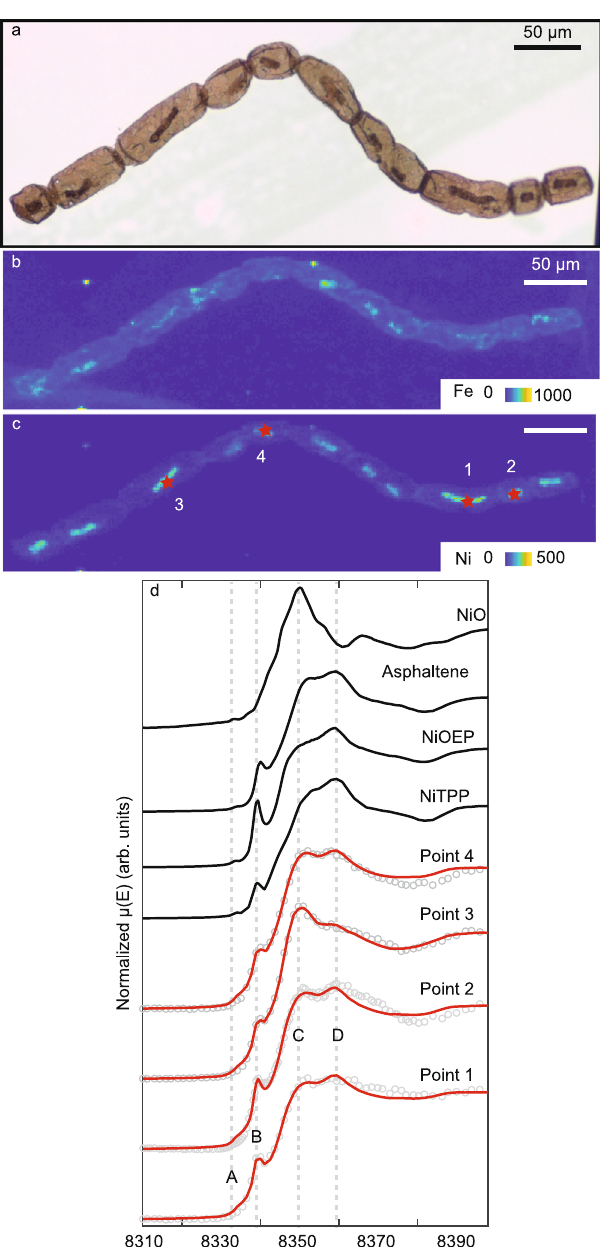
Fig. 3 Presence of tetrapyrrole moieties highlighted by XANES analyses on intracellular inclusions. a Microphotograph of the studied specimens. b , c Fe and Ni SR- μ XRF maps obtained at SLS (pixel: 1.5 μ m, 200 ms/px) showing the enrichment in Ni and Fe of the intracellular inclusions (ICI). Color scales correspond to normalized counts. d XANES spectra at the Ni K-edge of 4 ICIs performed in zones with low Fe content (gray circles) and their linear combination fi tting (red lines) and XANES spectra of two Ni-porphyrin (NiTPP: Ni(II)-tetraphenylporphine, NiOEP: Ni(II)-octaethylporphine) 43 , asphaltene 44 , and NiO standards. The shoulder and the spectral line shape are typical of Ni in coordination (IV) in bound Ni-porphyrinic species. Differences between the fi tted spectra and the data come from the molecular heterogeneities between the standards used for the fi tting and the incorporated tetrapyrroles moieties in the